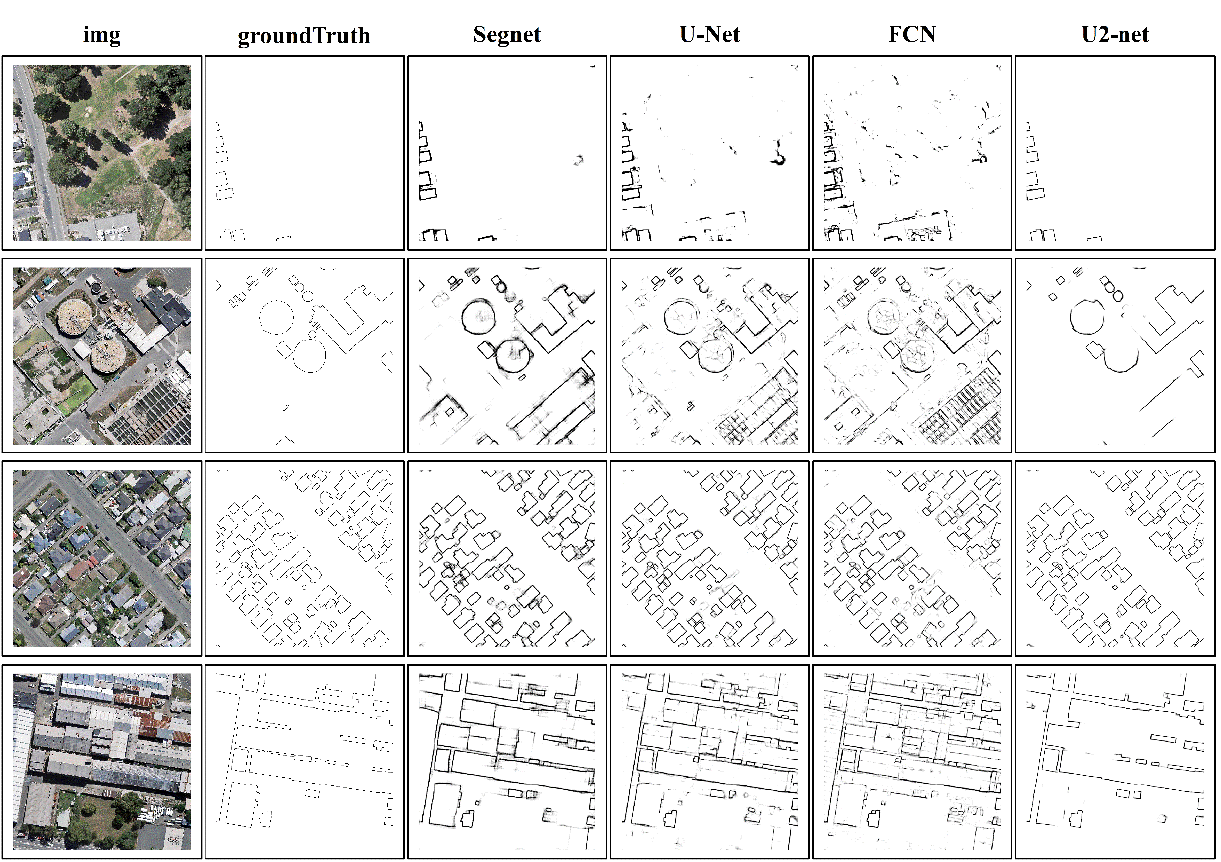
Figure 8. Visual comparison of different semantic segmentation models on WHU dataset.